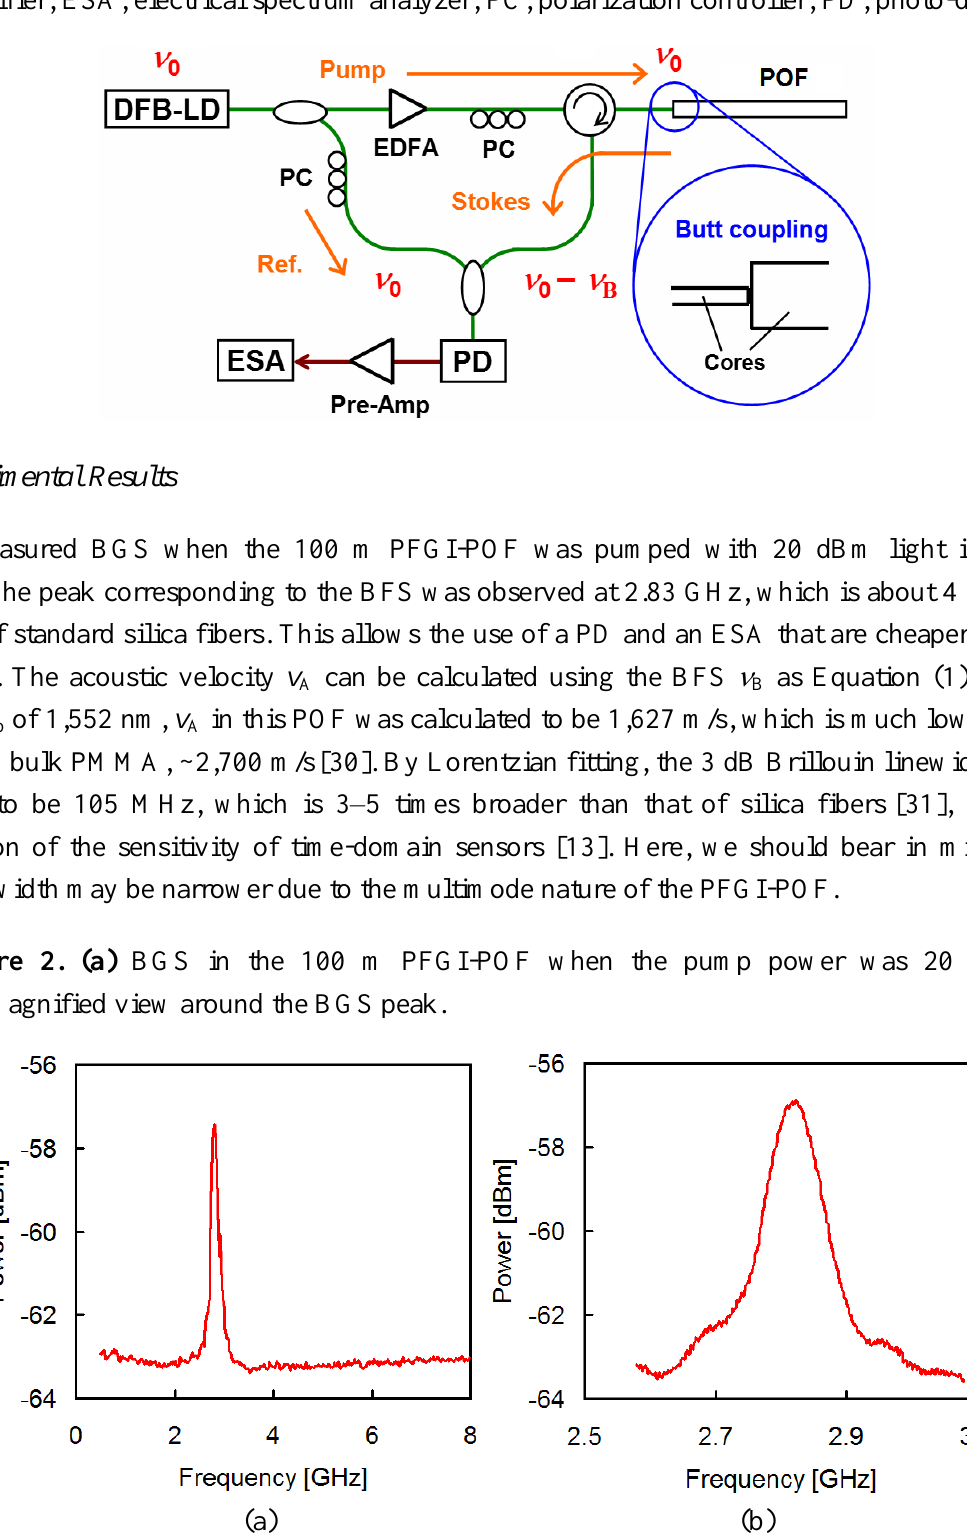
Figure 1. Experimental setup for investigating the Brillouin scattering properties in the PFGI-POF. DFB-LD, distributed-feedback laser diode; EDFA, erbium-doped fiber amplifier; ESA, electrical spectrum analyzer; PC, polarization controller; PD,